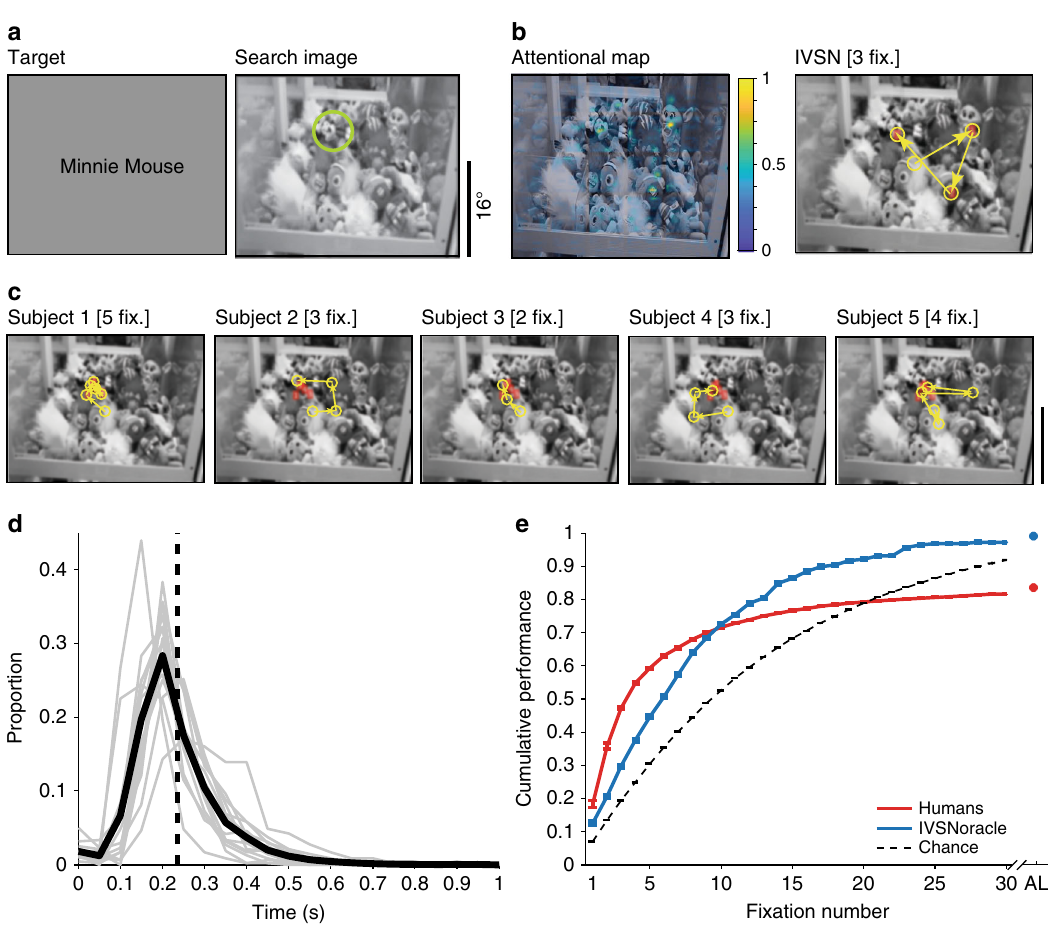
Fig. 4 Experiment 2 (Natural images). The format and conventions follow those in Fig. 3. Due to copyright, we replaced the picture of Minnie Mouse shown during the actual experiment in the target image ( a ) with the text “ Minnie Mouse